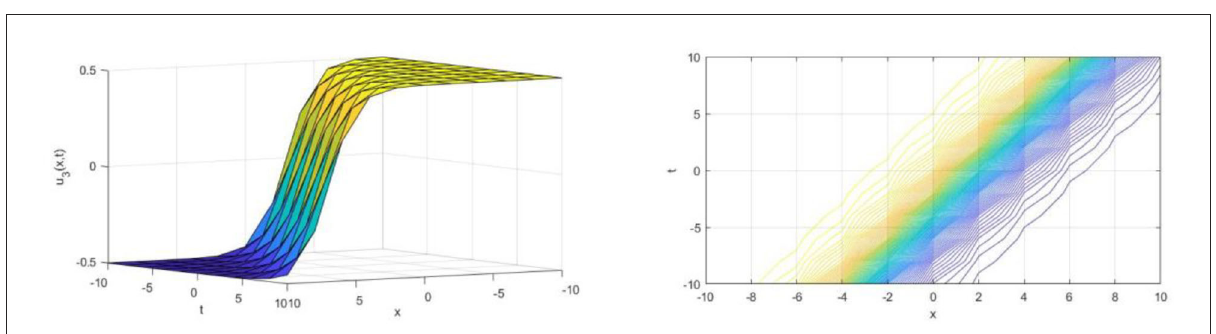
FIGURE3 The kink wave solution of u 3 ( x , t ) in 3D and